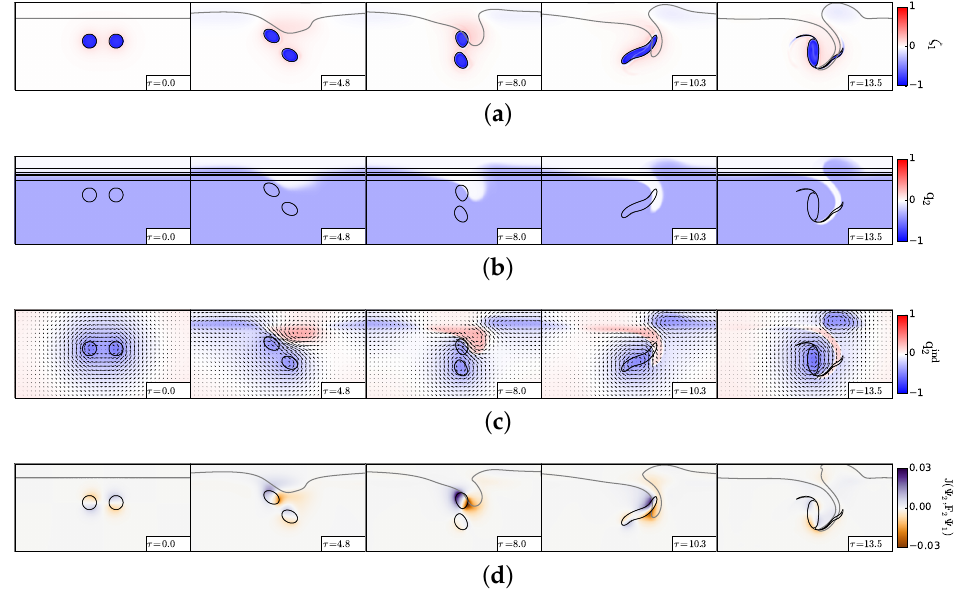
Figure 19. Merger of two anticyclones away from the slope for d / R = 3.8, γ R = 1, d c / R = 3. ( a ) Upper layer relative vorticity (Equation (3)); ( b ) lower layer potential vorticity (Equation (2)); ( c ) lower layer velocity and “equivalent barotropic” potential vorticity (Equation (11)); ( d ) Jacobian term of layer coupling F 2 J ( ψ 2 , ψ 1 ) . In (a,b,d), the black contours indicate the topographic slope (Equation (12); straight lines) and the upper layer vorticity contours showing the two vortex